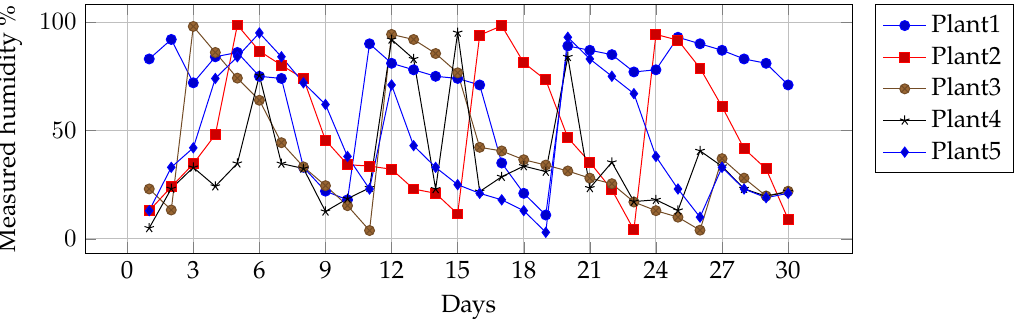
Figure 6: Humidity measured in plants irrigated manually